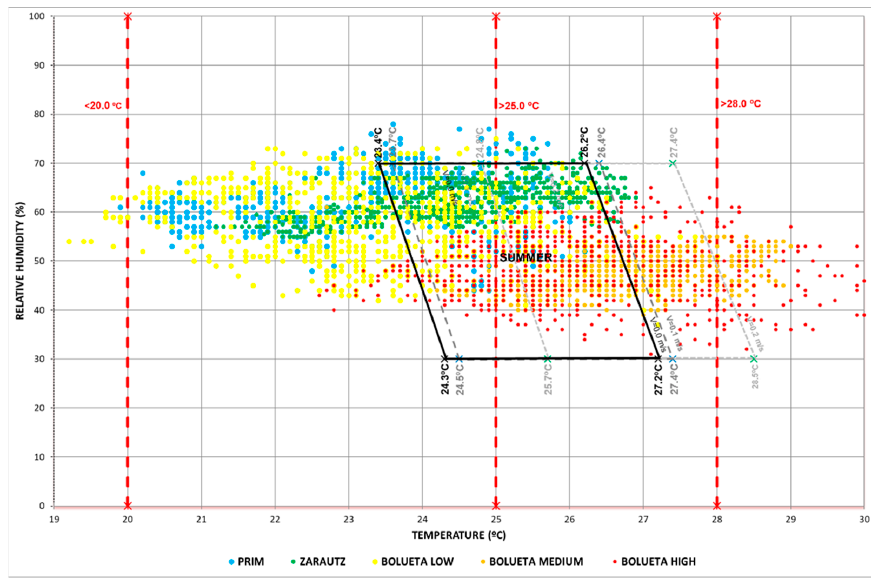
Figure 21. Summer comfort diagram for September 2020. Source: authors.